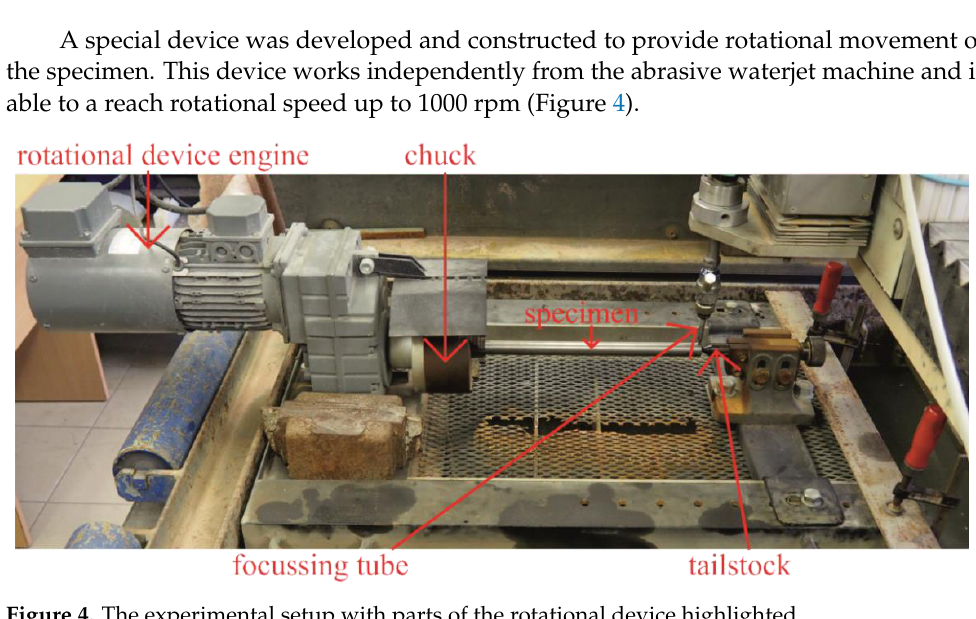
Figure 4. The experimental setup with parts of the rotational device highlighted.